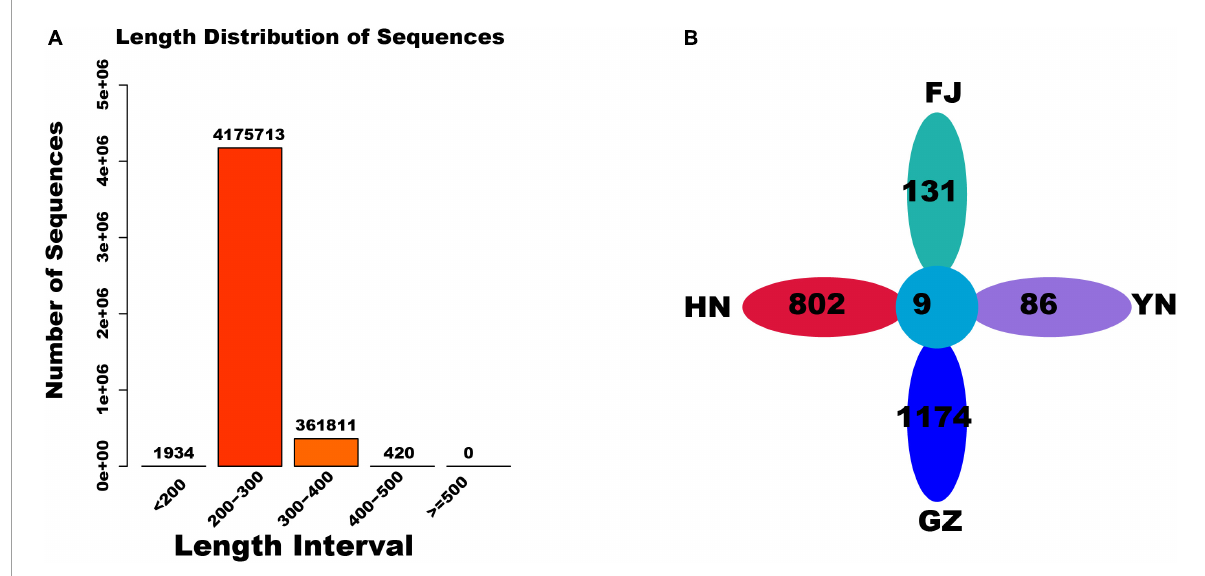
FIGURE2 The sequence feature and length distribution of endophytic fungi. (A) Length distribution of sequences; (B) the number of feature sequences in four